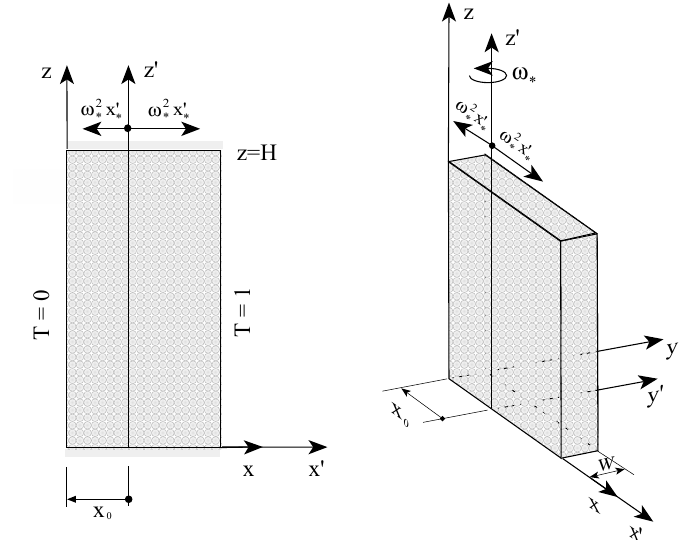
Figure 8. A rotating porous layer having the rotation axis within its boundaries and subject to different temperatures at the sidewalls (Reprinted from [41], with permission from Elsevier Science Ltd.)